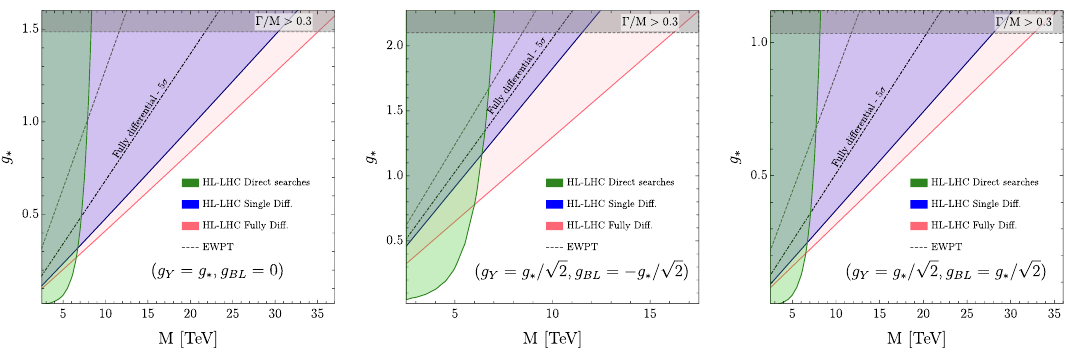
Figure 7 . HL-LHC 95% CL (1 d.o.f) exclusion reach in the mass/coupling plane for three different Z 0 benchmark models, namely g BL = 0 , g BL = − g Y and g BL = g Y . The blue shaded region can be excluded through the fully-differential di-lepton DY analysis, while the orange one can be probed with the invariant-mass fit. The green shaded region corresponds to the exclusion from direct